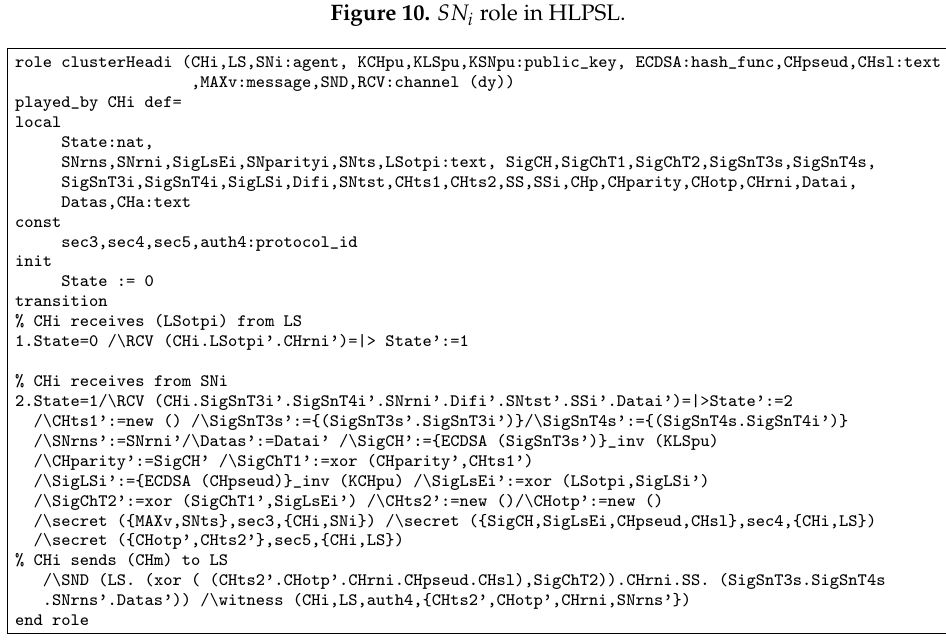
Figure 11. CH i role in